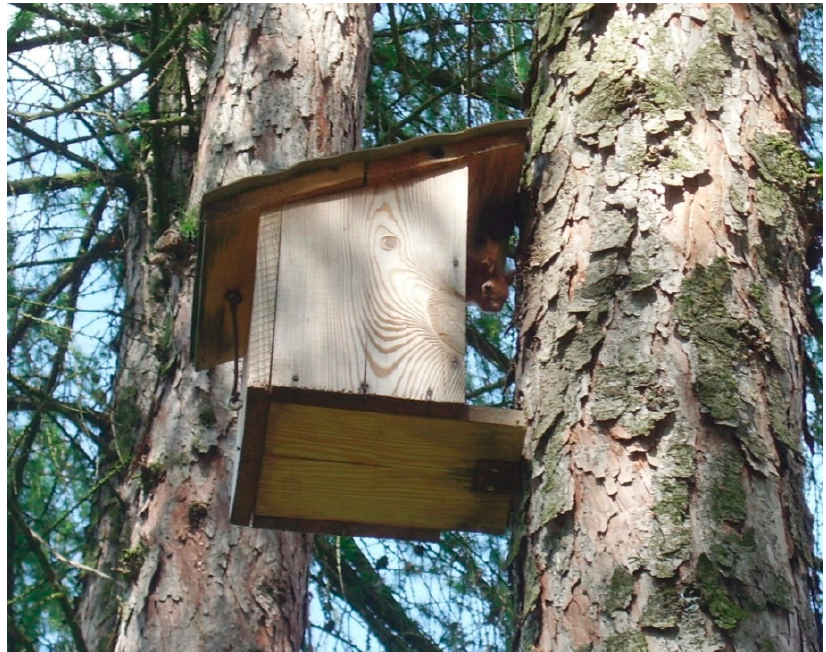
Figure A1. Young squirrel Sciurus vulgaris in one of the first nest boxes dedicated to the red squirrels in Poland. The nest box was placed in 2007 in central Poland and the next year a reproductive success was recorded in it. The box has an entrance hole at the back, i.e., facing the tree trunk. Such nest boxes were used in this study in the years 2013–2020.